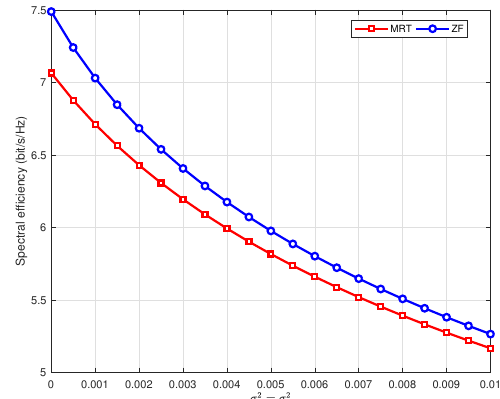
2 = σ 2 = σ 2 = φ , m φ ϕ , k